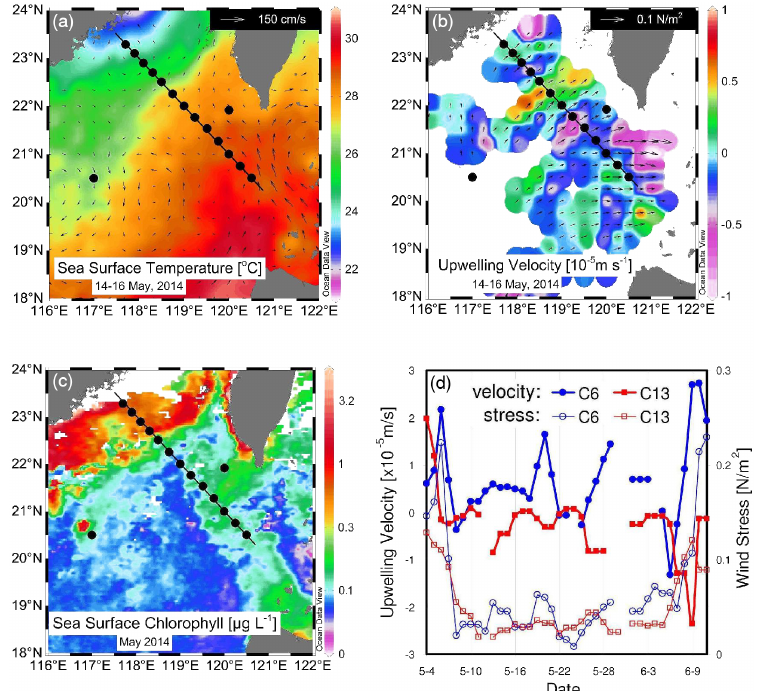
Figure 2. Spatial distributions of (a) sea surface temperature, (b) curl-driven upwelling velocity, and (c) sea surface chlorophyll during the survey, together with (d) the time-series of curl-driven upwelling and wind stress at stations C 6 and C 13 during the period May–June 2014. Vectors in panels (a) and (b) are surface geostrophic currents and wind stresses, respectively; geostrophic current is from OSCAR data; upwelling velocity and wind stress are from 3-day mean METOP-ASCAT data; sea surface temperature is 3-day-mean GOES-POES data; sea surface chlorophyll a is monthly MODIS-Aqua